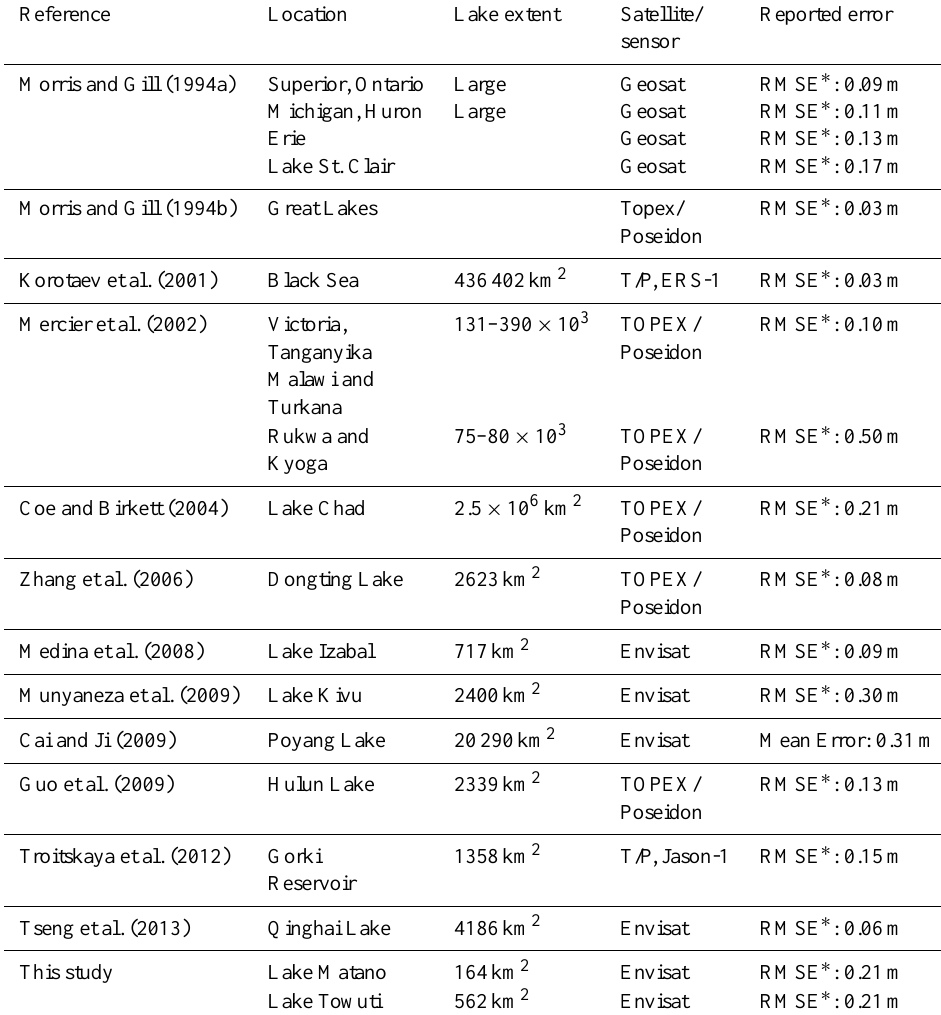
∗ RMSE = root mean square